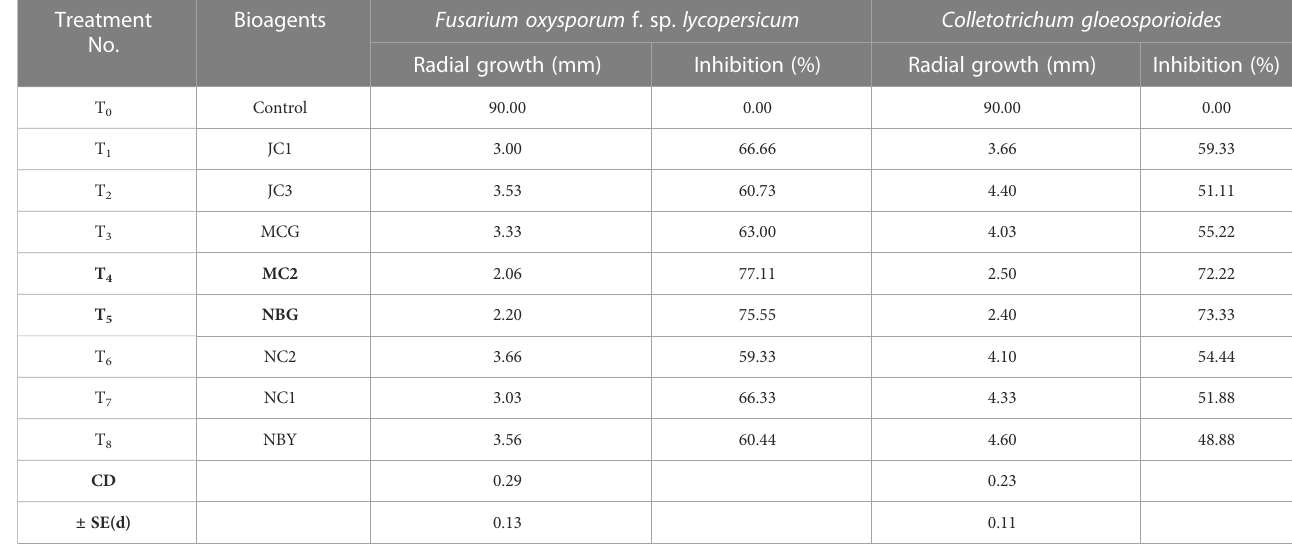
TABLE 4 Effect of volatile compound production of promising rhizospheric microbes on fungal pathogens. Treatment No.